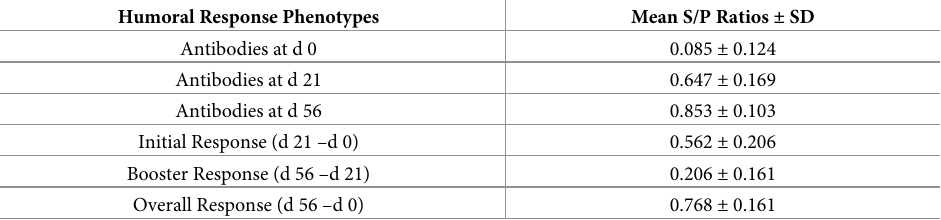
Table 1. Humoral response to vaccination with E . coli O157:H7 Siderophore and Porin Receptor (SRP) proteins as measured by an ELISA specific for E . coli O157:H7 SRPs ( n =